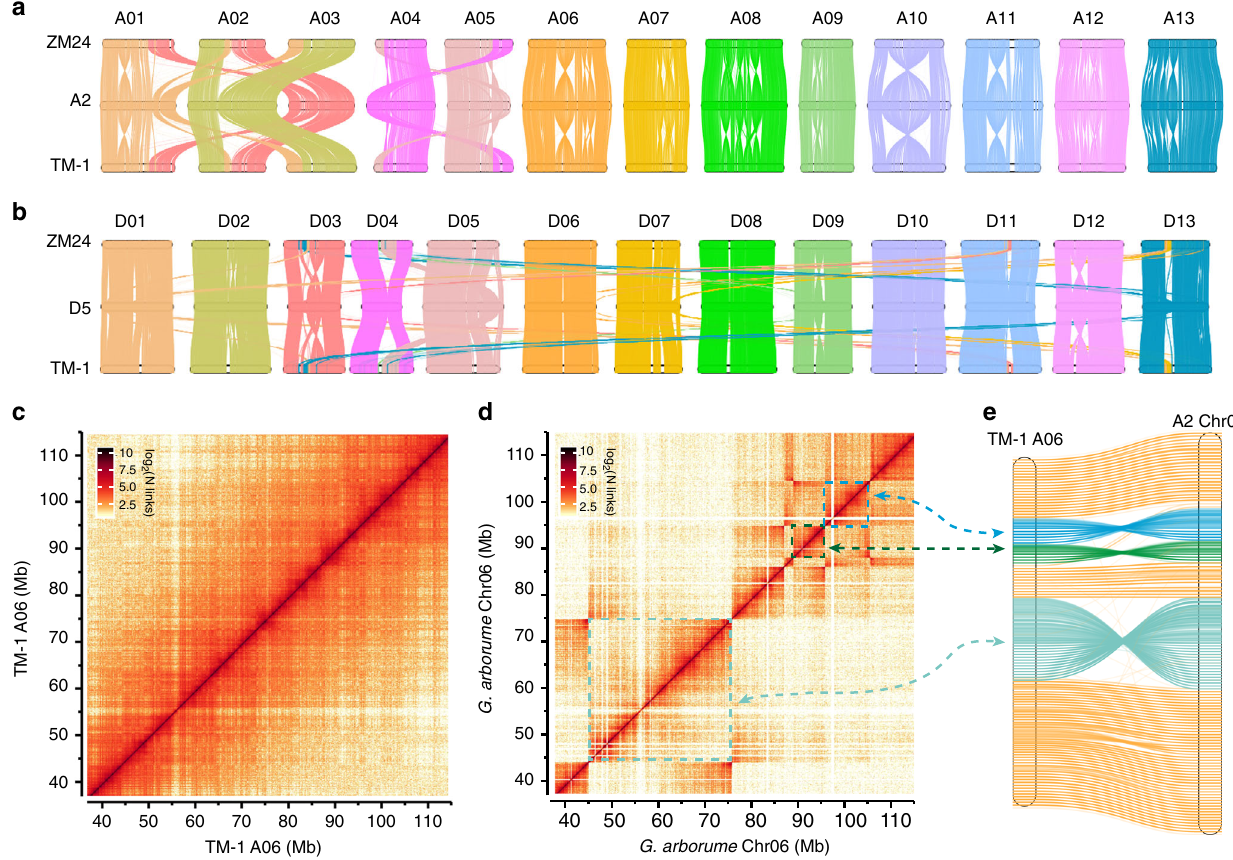
Fig. 1 Comparison of the assembled genomes with their diploid progenitors genomes. a Whole genome comparison among the TM-1 A t subgenome, the G. arboreum genome (A 2 ), and the ZM24 A t subgenome. b Whole genome comparison among the TM-1 D t subgenome, ZM24 D t subgenome. c , d TM-1 Hi-C data mapped to TM-1 A06 and G. arboreum Chr06. The dotted boxes indicate the inversions between A06 and Chr06. e Genome comparison of TM-1 A06 and G. arboreum Chr06. The double arrow dash line indicated the same inversions between the Hi-C map and Chromosomes. Source data of ( a , b ) are provided in a Source Data fi le NATURE COMMUNICATIONS| (2019) 10:2989